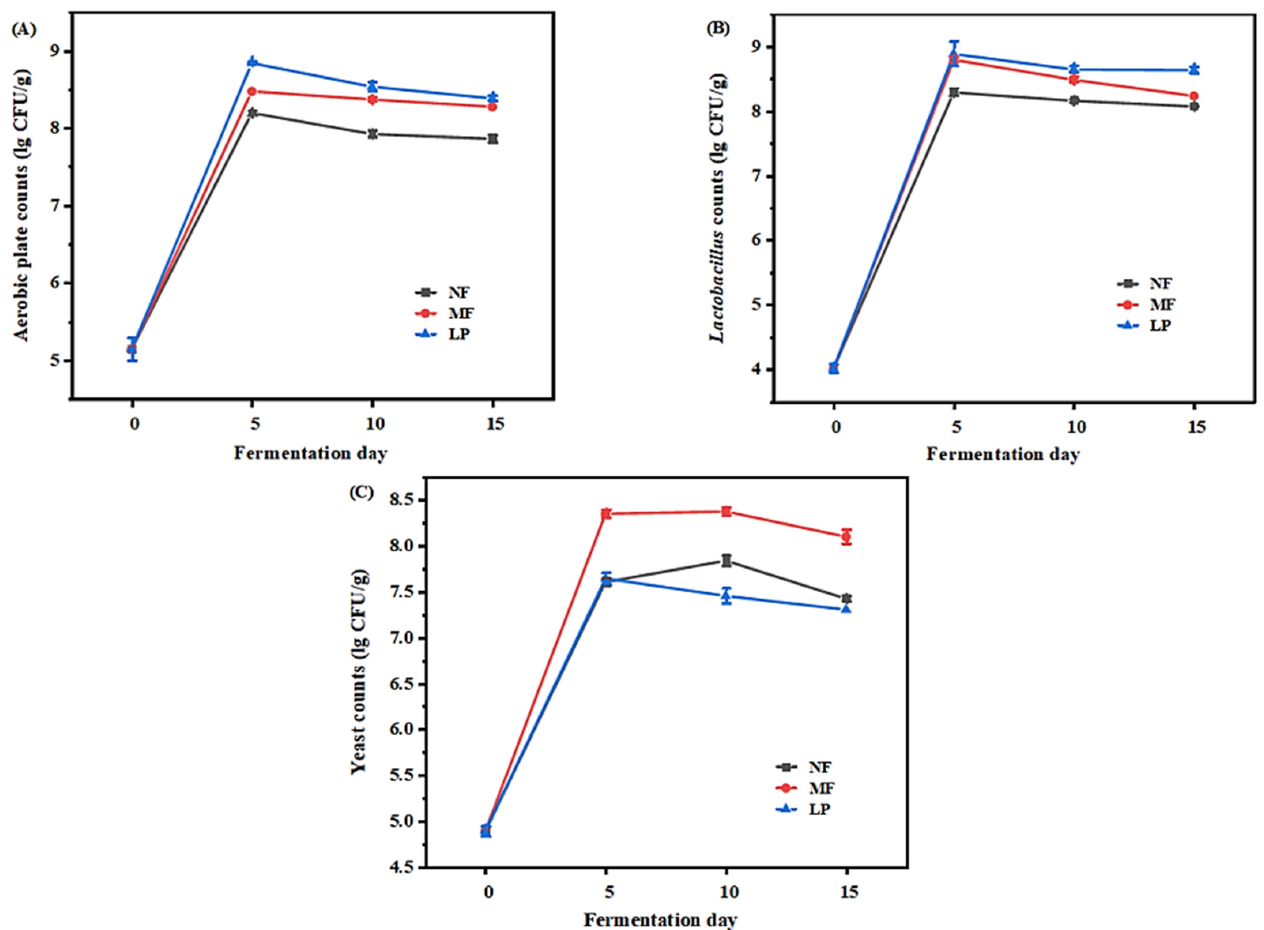
Figure 2. Changes in the aerobic plate counts ( A ), Lactobacillus counts ( B ), and yeast counts ( C ) of Suanyu samples with different fermentation conditions during fermentation. NF, natural fermenta- tion; LP, inoculated L. plantarum ; MF, inoculated L. plantarum combined with S. cerevisiae